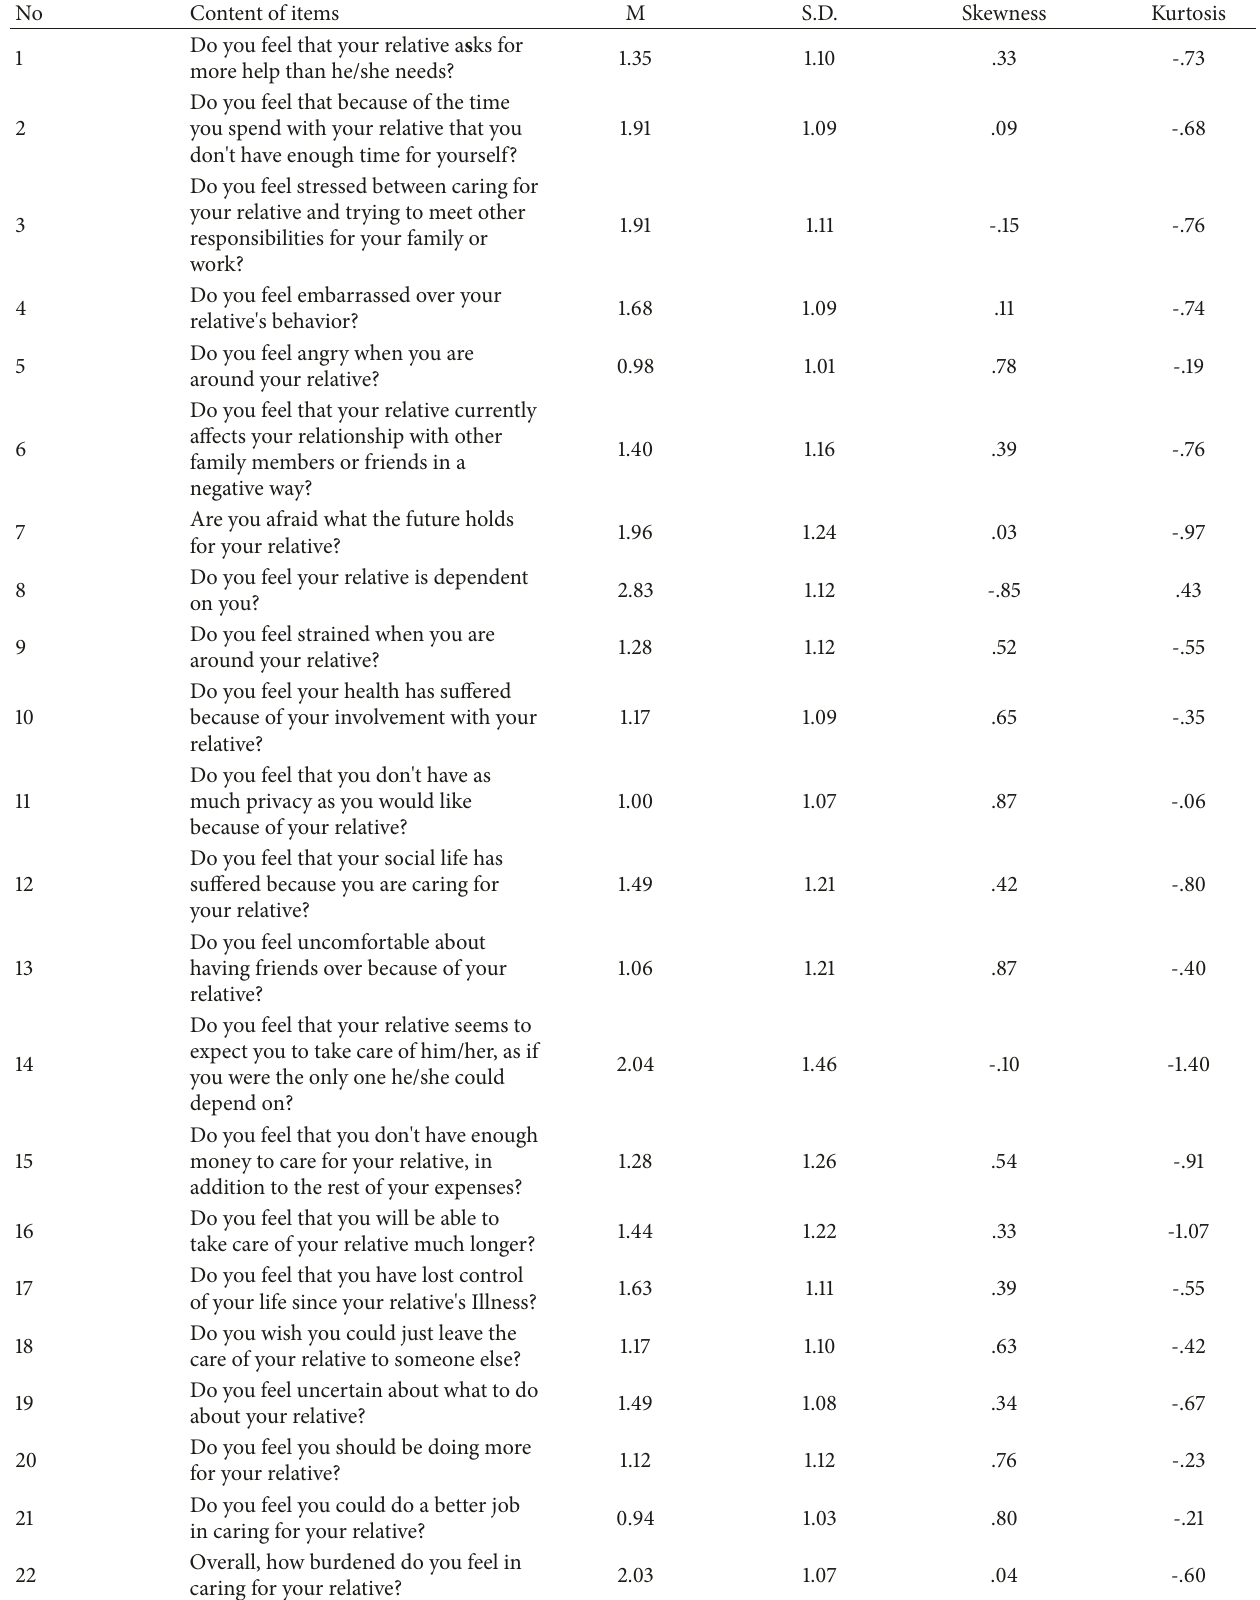
Table 2: The original version of the Zarit Caregiver Burden Interview